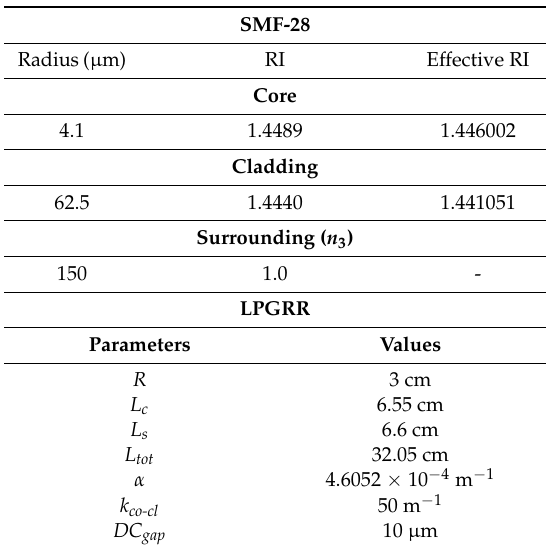
Table 2. Coupling efficiency, transmission and coupling coefficients calculated with the Supermodes Theory in a 6.55 mm-long coupling region for both the core and cladding modes.